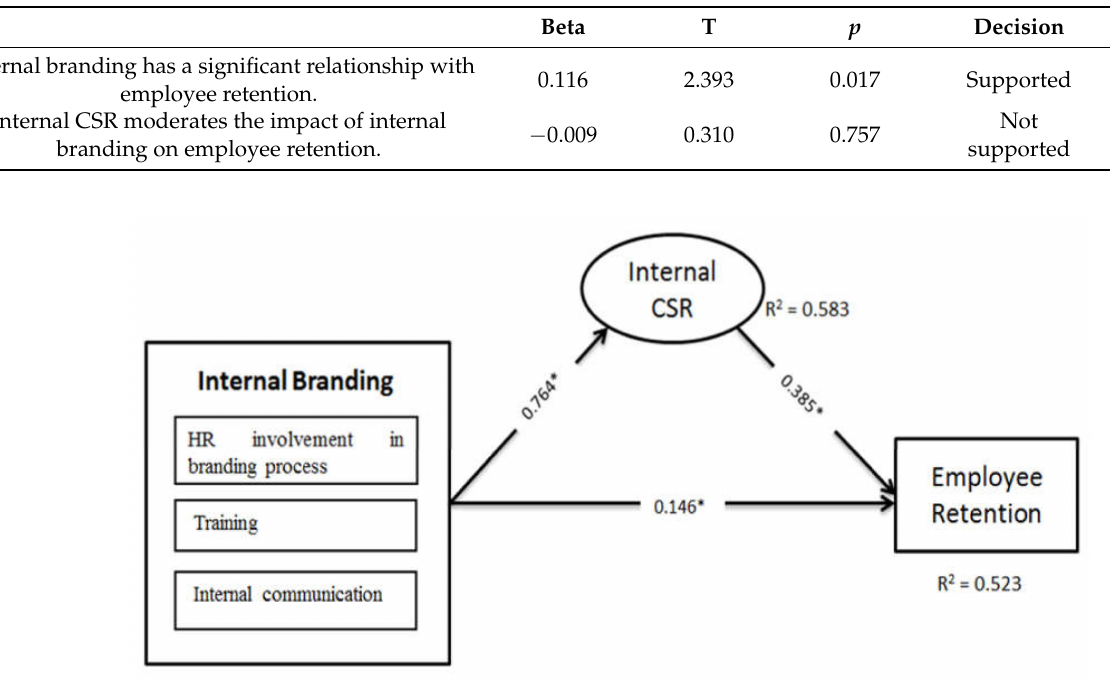
Table 5. Hypotheses Testing.